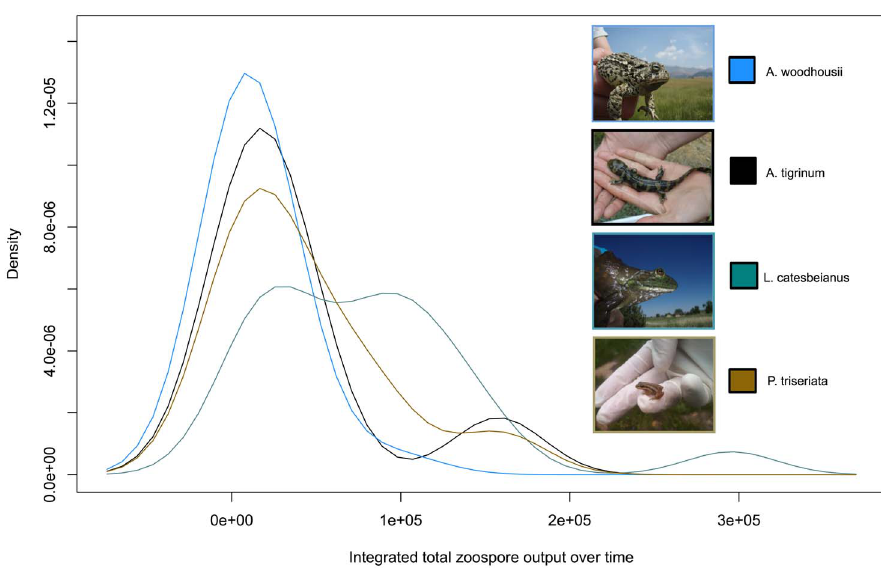
Figure 4. Kernal density plot representing the distribution of the integrated zoospore output over time for individuals. Species included in the laboratory infection: Ambystoma tigrinum individuals (n=8), Anaxyrus woodhousii individuals (n=25), Pseudacris triseriata individuals (n=12) and Lithobates catesbeianus individuals (n=21). Total zoospore output over time calculated by taking Simpson’s numeric integral to find area under curve of zoospore output over time for each individual.